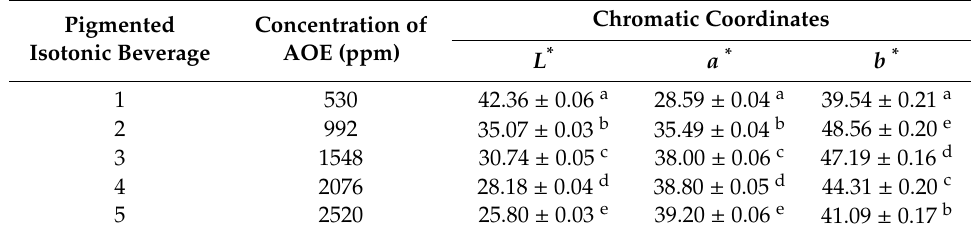
X ± S: mean value ± standard deviation. Different letters in the column values indicate statically significant differences for p < 0.05.